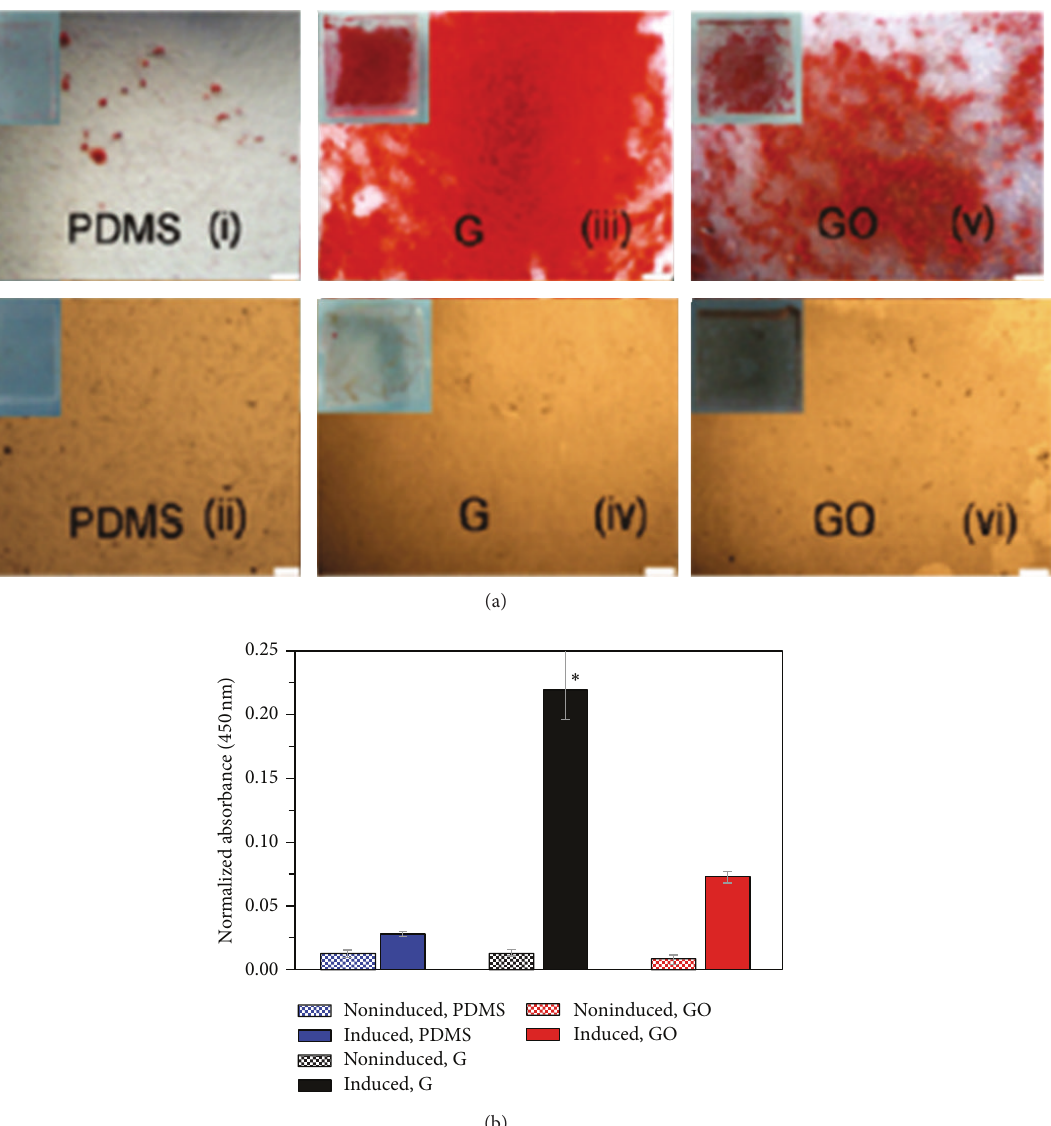
Figure 3: (a) Alizarin Red staining after 12 days of incubation of BMSC on PDMS, graphene (G), and GO with ((i), (ii), and (iv)) and without osteogenic medium ((ii), (iv), and (vi)). (b) Quantification demonstrated a significantly higher amount of Alizarin Red staining in the MSCs differentiated on graphene. Reprinted with permission from [33] (Copyright (2011) American Chemical